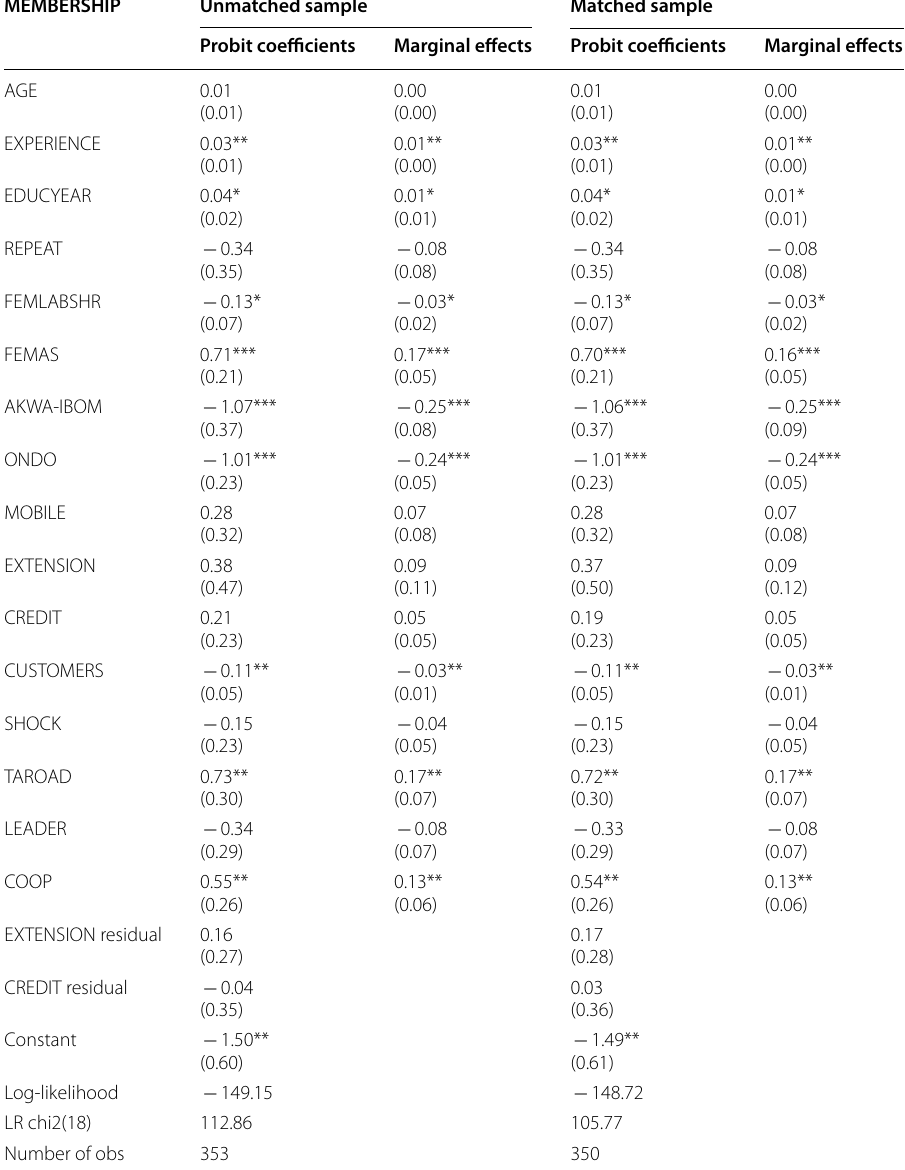
Table 3 Probit model estimates of the determinant of membership in fisher